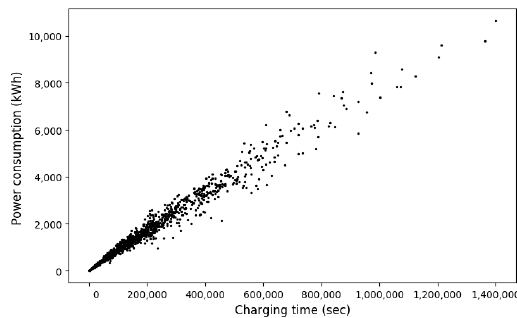
Figure 4. New electric power consumption distribution obtained by integrating the data of Figure 2 for a specific period (units: charging time (sec), power consumption